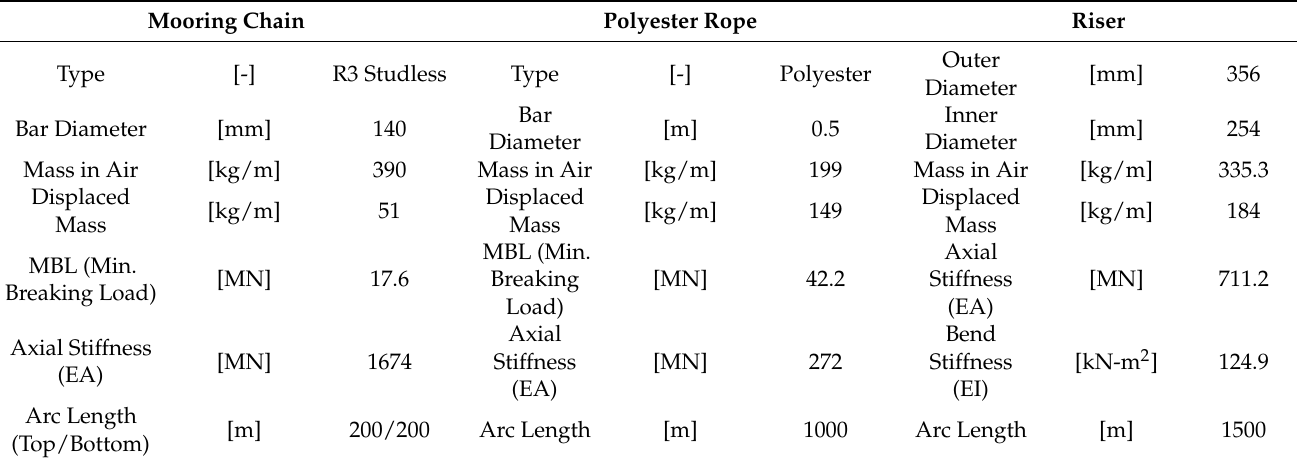
Table 2. Mooring and Riser